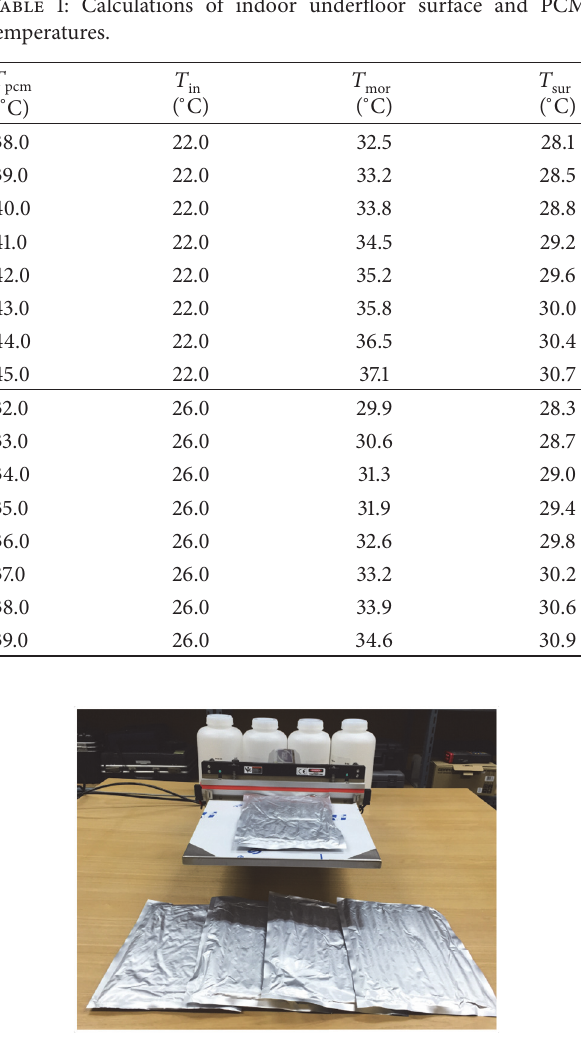
perform thermal storage and discharge through a phase change is